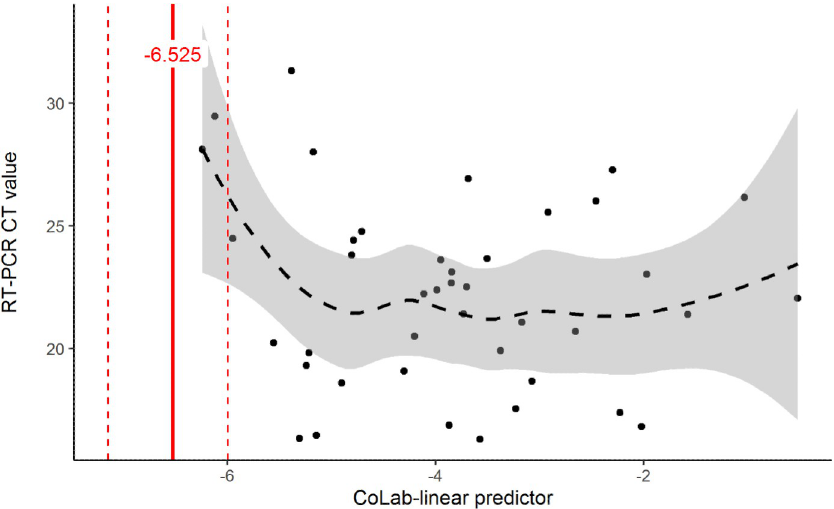
Fig 5. CoLab-linear predictor versus RT-PCR CT value. The CoLab-linear predictor is plotted versus the RT-PCR CT value. The red line is the CoLab-linear predictor cut-off below which HCWs are regarded as non-COVDI 19, the dashed red lines represent the 95% CI of the cut-off. The dashed line is a LOESS smooth where the 95% confidence interval is shown in gray.